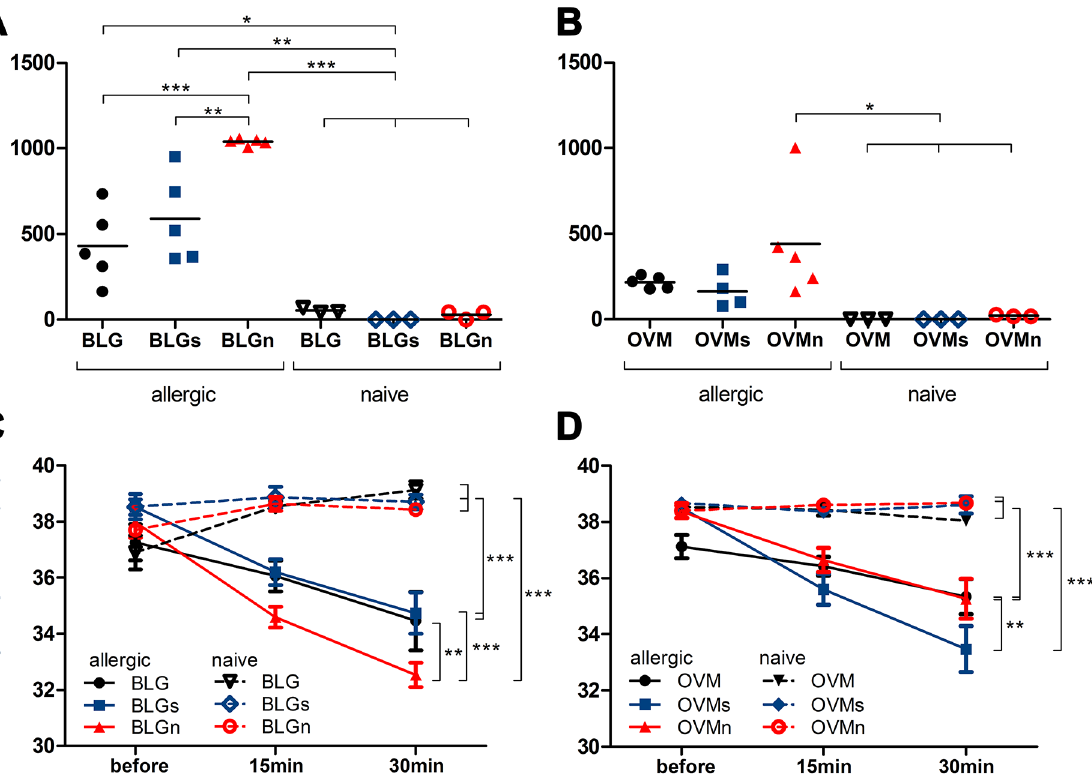
Fig 3. Nitrated BLG enhances the anaphylactic response in BLG immunized animals. After i.v. allergen challenge all BLG immunized groups showed significantly elevated levels of the anaphylaxis marker mMCP-1 compared to na ï ve control groups (A). Allergic mice injected with nitrated BLG (BLGn) revealed a significantly higher mMCP-1 release compared to mice only receiving untreated (BLG) or sham-nitrated (BLGs) BLG. Systemic challenge of allergic mice with different preparations of OVM did not result in differences of mMCP-1 between OVM, OVMs and OVMn (B). Mouse MCP-1 concentrations were compared with One-way ANOVA. Body temperature of all groups was assessed before and 15 and 30 min after i.v. challenge (C, D). A significant drop of body temperature was observed in all allergic mice. Animals challenged with BLGn showed a significant decline of body temperature compared to BLG and BLGs, while in OVM allergic mice decrease was most prominent in OVMs. Mean temperatures of all groups at 30 min were compared using One-way ANOVA prior to Tukey multiple comparison test ( * P > 0.05, ** P < 0.01, *** P < 0.001). BLG, beta-lactoglobulin; BLGn, nitrated BLG; BLGs, sham-nitrated BLG; i.v., intravenous; mMCP-1, mouse mast cell protease-1; OVM, ovomucoid; OVMn, nitrated OVM; OVMs, sham-nitrated